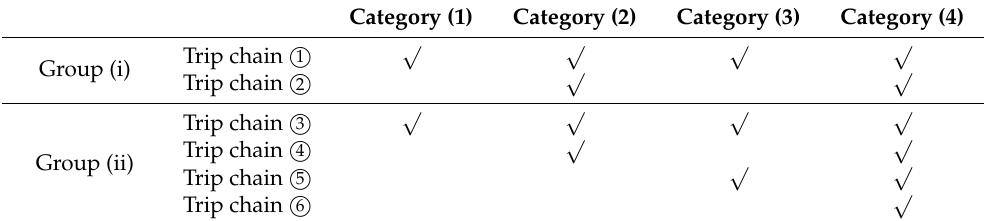
Figure 3. Candidate trip chains. Table 5. Candidate trip chains for affected passengers of different categories.